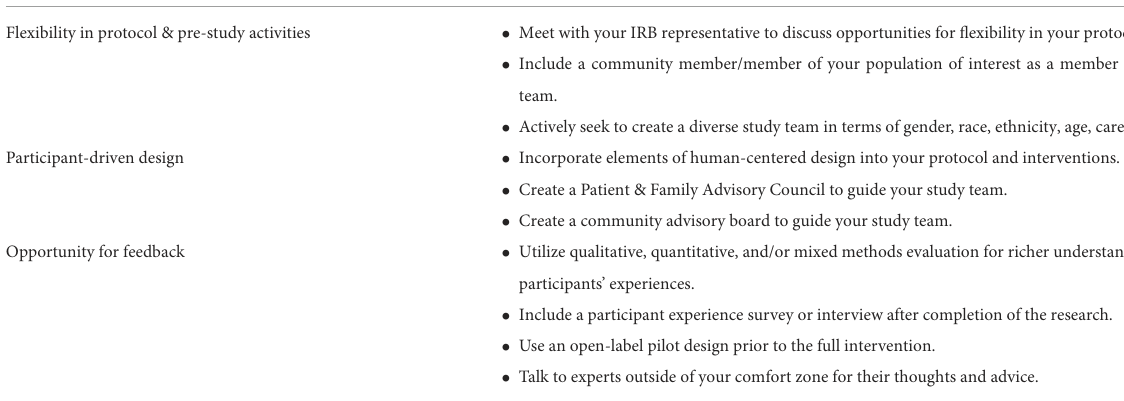
TABLE 1 Our guiding questions and proposed